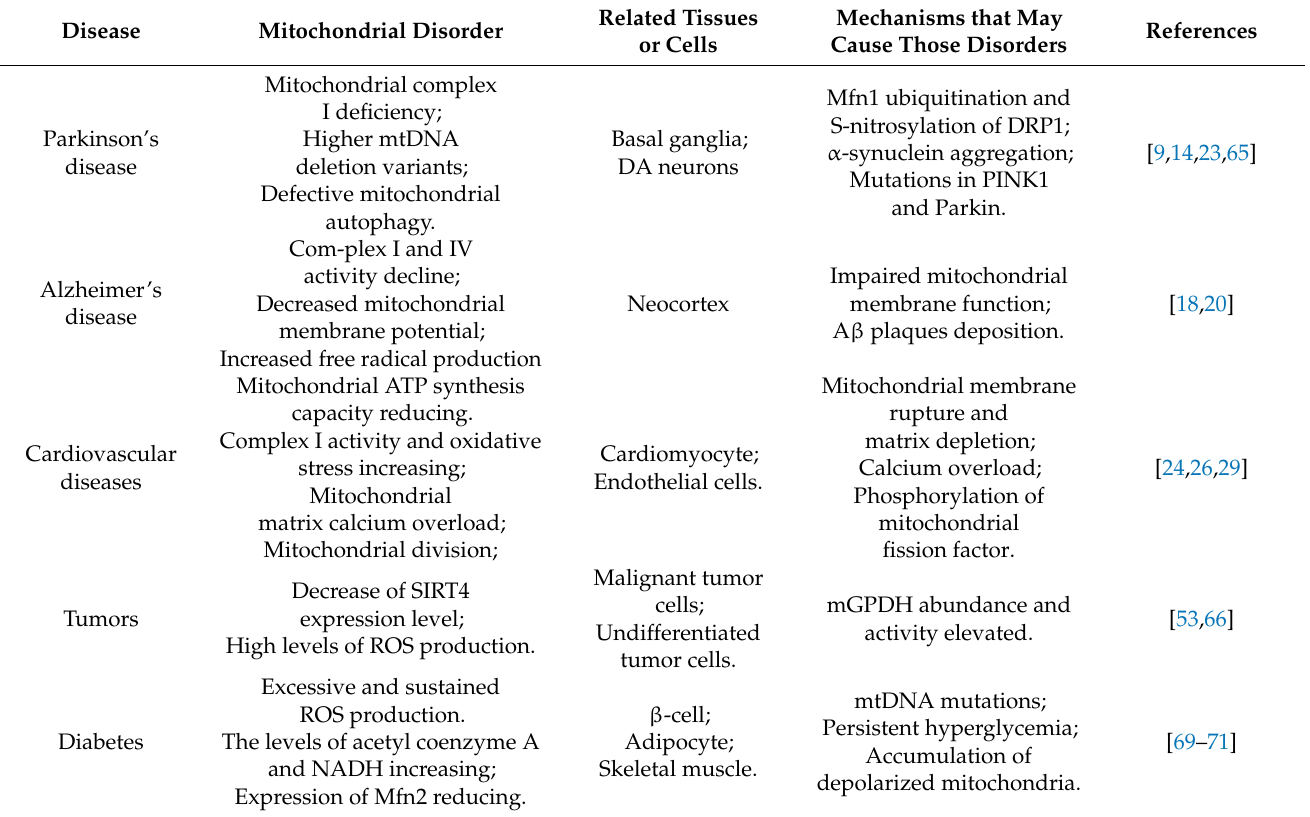
Table 1. Mitochondrial dysfunction in common diseases and possible